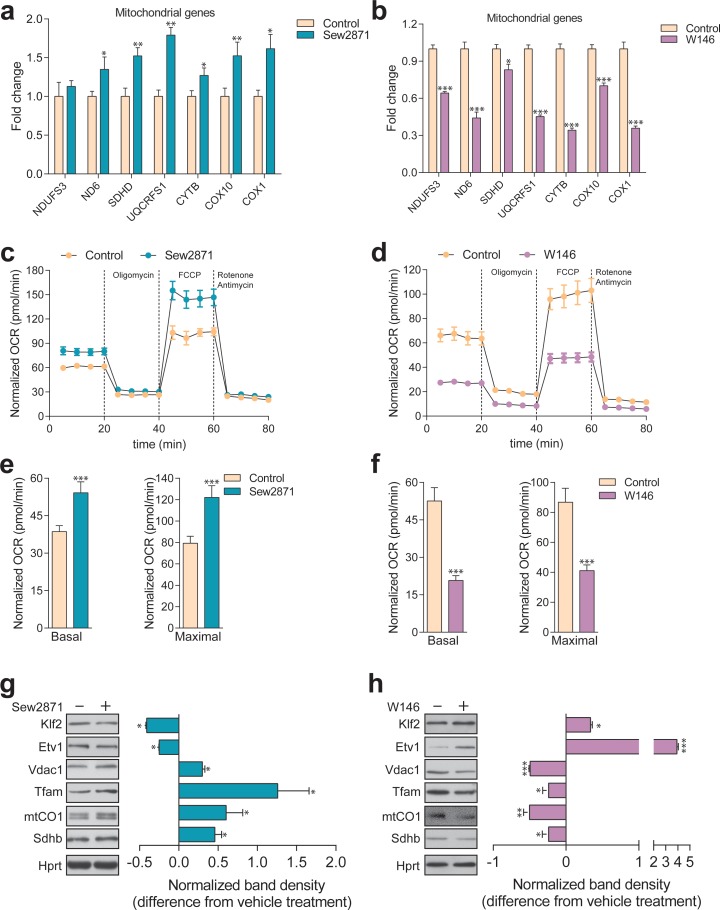
Dynamic regulation of S1PR1 activity impacts mitochondrial biogenesis and function.(a) Transcript levels of mitochondrial-related genes increase upon activation of S1PR1 with the agonist Sew2871 (5 µM, 16 hr; DMSO as vehicle control), as measured by qPCR. Plots show mean ± s.e.m., n = 3. T-test p-values *p<0.05 and **p<0.01 (b) Transcript levels of mitochondrial-related genes decrease upon inhibition of S1PR1 with the competitive antagonist W146 (10 µM, 16 hr; methanol as vehicle control), as measured by qPCR. Plots show mean ± s.e.m., n = 3. T-test p-values **p<0.01 and ***p<0.001 (c) Increased OCR in cells treated with the S1PR1 agonist Sew2871 compared to vehicle control (DMSO), quantified in panel (e). (d) Decreased OCR in cells treated with the S1PR1 antagonist W146 compared to vehicle control (methanol), quantified in panel (f). Quantifications in e and f represent mean ± s.em., n = 3 with T-test p-values ***p<0.001. (g) Representative blots showing decreased protein levels of KLF2 and ETV1, and increased amounts of mitochondrial proteins VDAC1, TFAM, CO1 and SDHB, in cells treated with S1PR1 agonist Sew2871, assessed by western blots of whole cell extracts, using HPRT as loading control. Adjacent plot depicts the fold difference in band density relative to vehicle control (DMSO) as mean ± s.e.m., n = 2 with technical triplicates (the line on zero denotes no change relative to the controls, negative numbers show decrease in fold change, positive numbers show increased fold change). T-test p-value *p<0.05 (h) Representative blots depicting increased protein levels of KLF2 and ETV1, and decreased amounts of mitochondrial proteins VDAC1, TFAM, CO1 and SDHB, in cells treated with S1PR1 antagonist W146, assessed by western blots of whole cell extracts, using HPRT as loading control. Adjacent plot shows the difference in fold band density compared to vehicle control (methanol) and depicted as average ± s.e.m., n = 2 with technical triplicates. T-test p-value *p<0.05, **p<0.01 and ***p<0.001.